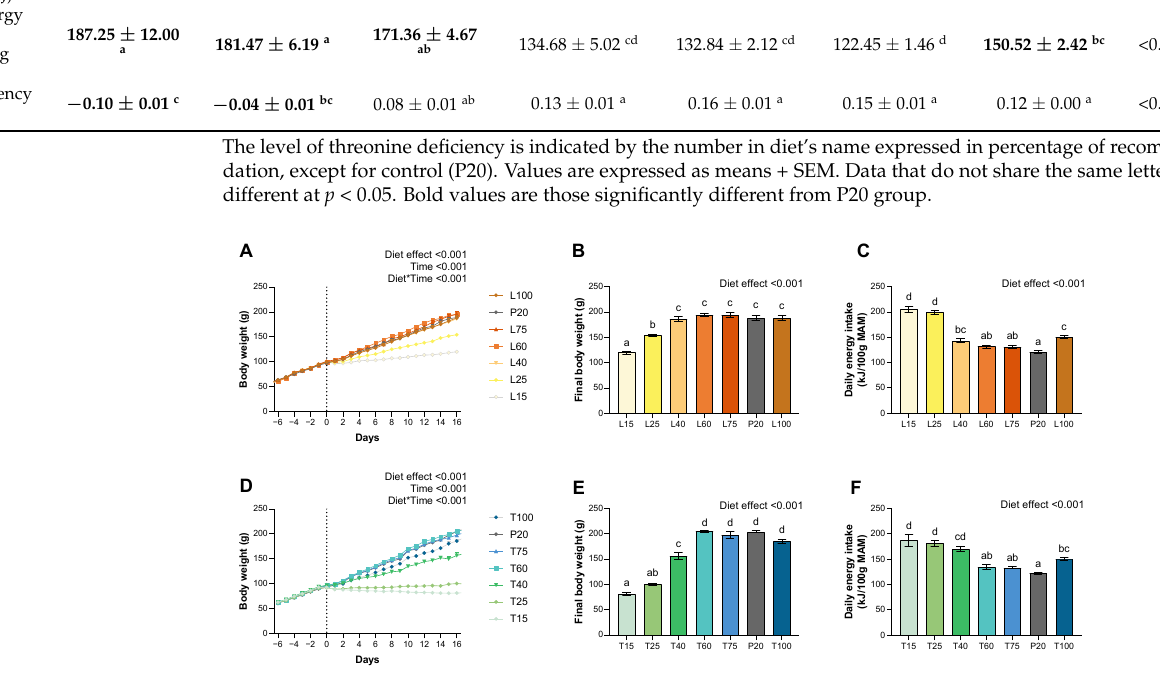
Figure 1. Effect of lysine or threonine deficiency on body weight gain, final body weight, and energy intake. ( A ) Evolution of body weight under lysine diets. ( B ) Final body weight for lysine diets on day 16. ( C ) Daily energy intake for lysine diets. ( D ) Evolution of body weight under threonine diets. ( E ) Final body weight for threonine diets on day 16. ( F ) Daily energy intake for threonine diets. Data that do not share the same letter are different at p < 0.05. Values are expressed as means + SEM. Lysine severe deficient groups (L15 and L25) have a significantly reduced BW gain from day 3 and 6, respectively ( p < 0.001) (Figure 1). Under lysine diets, no difference was significant between the moderately deficient (L40 and L60) or adequate (L75 and L100) groups and the P20 group. Threonine severe deficient groups (T15 and T25) have a signif- icantly reduced BW gain from day 1, and the lowest moderately deficient group (T40) from day 6 ( p < 0.001) (Figure 1). Under threonine diets, no difference was significant be-